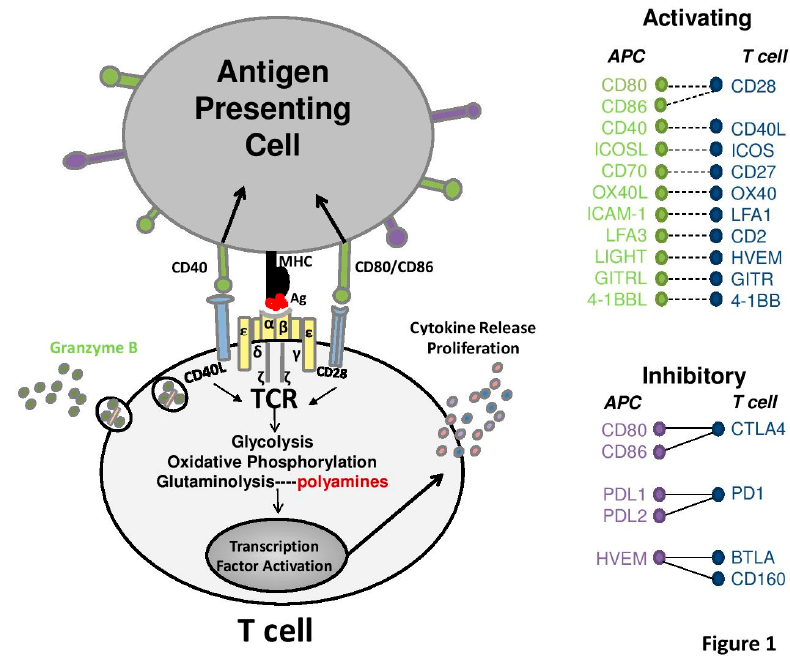
Figure 1. Stimulatory and inhibitory molecules expressed on T-cells. Diagram depicting the antigen presenting cell (APC) and T-cell interactions and activating receptors and ligands on these cells that govern the functional outcomes of T-cells such as cytotoxicity-associated granzyme B expression, cytokine release, and proliferation [61]. The T-cell receptor complex is composed of several proteins that are necessary for survival and signaling including T-cell receptor (TCR) α and TCR β chains, CD3 signaling molecules δ / ε , CD3 γ / ε and CD247 composed on the dimeric ζζ -chains or ζ n (not shown). Co-stimulatory molecules on T-cells such as CD28, the founding member of the immunoglobulin (Ig) family of costimulatory receptors, are critical to amplify and sustain the signaling response. Activation leads to metabolic reprogramming to increase glycolysis, oxidative phosphorylation, and amino acid metabolism through glutaminolysis and ultimately to polyamine biosynthesis [62,63]. Additional receptors include CD40L (CD154), T-cell specific surface glycoprotein CD28, inducible T-cell costimulatory ICOS (CD278) which is a CD28-family molecule expressed on T-cells important for Th2 responses, Traf-linked tumor necrosis factor receptor family protein, CD27, which is important in T and B-cell memory formation and activation of natural killer (NK) cells [64–66], tumor necrosis factor receptor superfamily (TNFRSF), member 4 (TNFRSF4) also OX40 (CD134) expressed on activated T-cells [51–53], leukocyte-associated antigen-1 (LFA1) which is an integrin involved in T-cell migration [53,67], the adhesion molecule CD2 present on T-cells and NK cells (also known erythrocyte receptor and rosette receptor, LFA-2), herpesvirus entry mediator (HVEM) also known as tumor necrosis factor receptor superfamily member 14 (TNFRSF14), glucocorticoid-induced TNFR family related gene (GITR) a member of the TNFRSF [68], S-type lectin Galectin 9, T-cell immunoglobulin mucin domain 1 (TIM1) also known as hepatitis A virus cellular receptor 1 (HAVcr-1), and 4-1BB (CD137, TNFRS9). Corresponding receptors on APC are the classical costimulatory ligands CD80 (B7-1), CD86 (B7-2) that interact with CD28, TNFRS5 (CD40), human inducible costimulatory-ligand (ICOSL) [69], ligand for CD27 (CD70 also TNFSF7), OX40 ligand (OX40L), intercellular adhesion molecule 1 (ICAM-1, also CD54), leukocyte-associated antigen-3 (LFA3), HVEM counter-receptor lymphotoxin-like, exhibits inducible expression, and competes with herpes simplex virus glycoprotein D for HVEM, a receptor expressed by T-lymphocytes (LIGHT, also CD160), GITR ligand (GITRL), and 4-1BB ligand (4-1BBL). Inhibitory receptors and ligands are shown including cytotoxic T-lymphocyte antigen-4 (CTLA4) which interacts with CD80, CD86 that also recognizes CD28, programmed cell death protein 1 (PD1) receptor and its ligands PD-ligand 1 (PDL1) and PD-ligand 2 (PDL2), and B-and T-lymphocyte attenuator (BTLA) and CD160 [70] that both recognize HVEM. MHC: major histocompatibility complex, Ag: antigenic peptide.